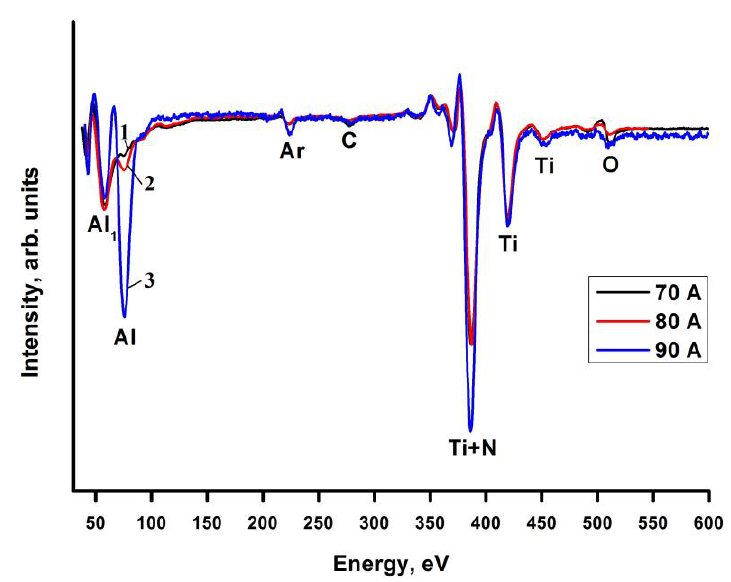
Figure 2. Auger electron spectroscopy (AES) of Ti-Al-N coatings at I Al : 1–70 A; 2–80 A; 3–90A.